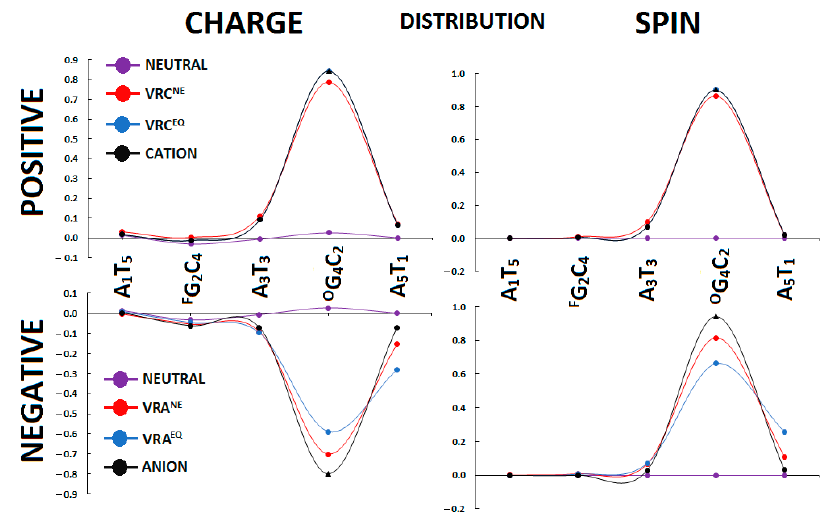
Figure 4. Spin and charge distribution within oligo- Faoy G calculated at the M062x/6-31++G** level of theory in the condensed phase; only the stacked base pairs were taken into consideration. VRC—vertical radical cation, VRA—vertical radical anion, NE—non-equilibrated, and EQ—equilibrated solvent–solute interaction. The charge and spin distribution of vertical and adiabatic forms. The raw data have been given in Table S2. F = Fapy, O = OXO.